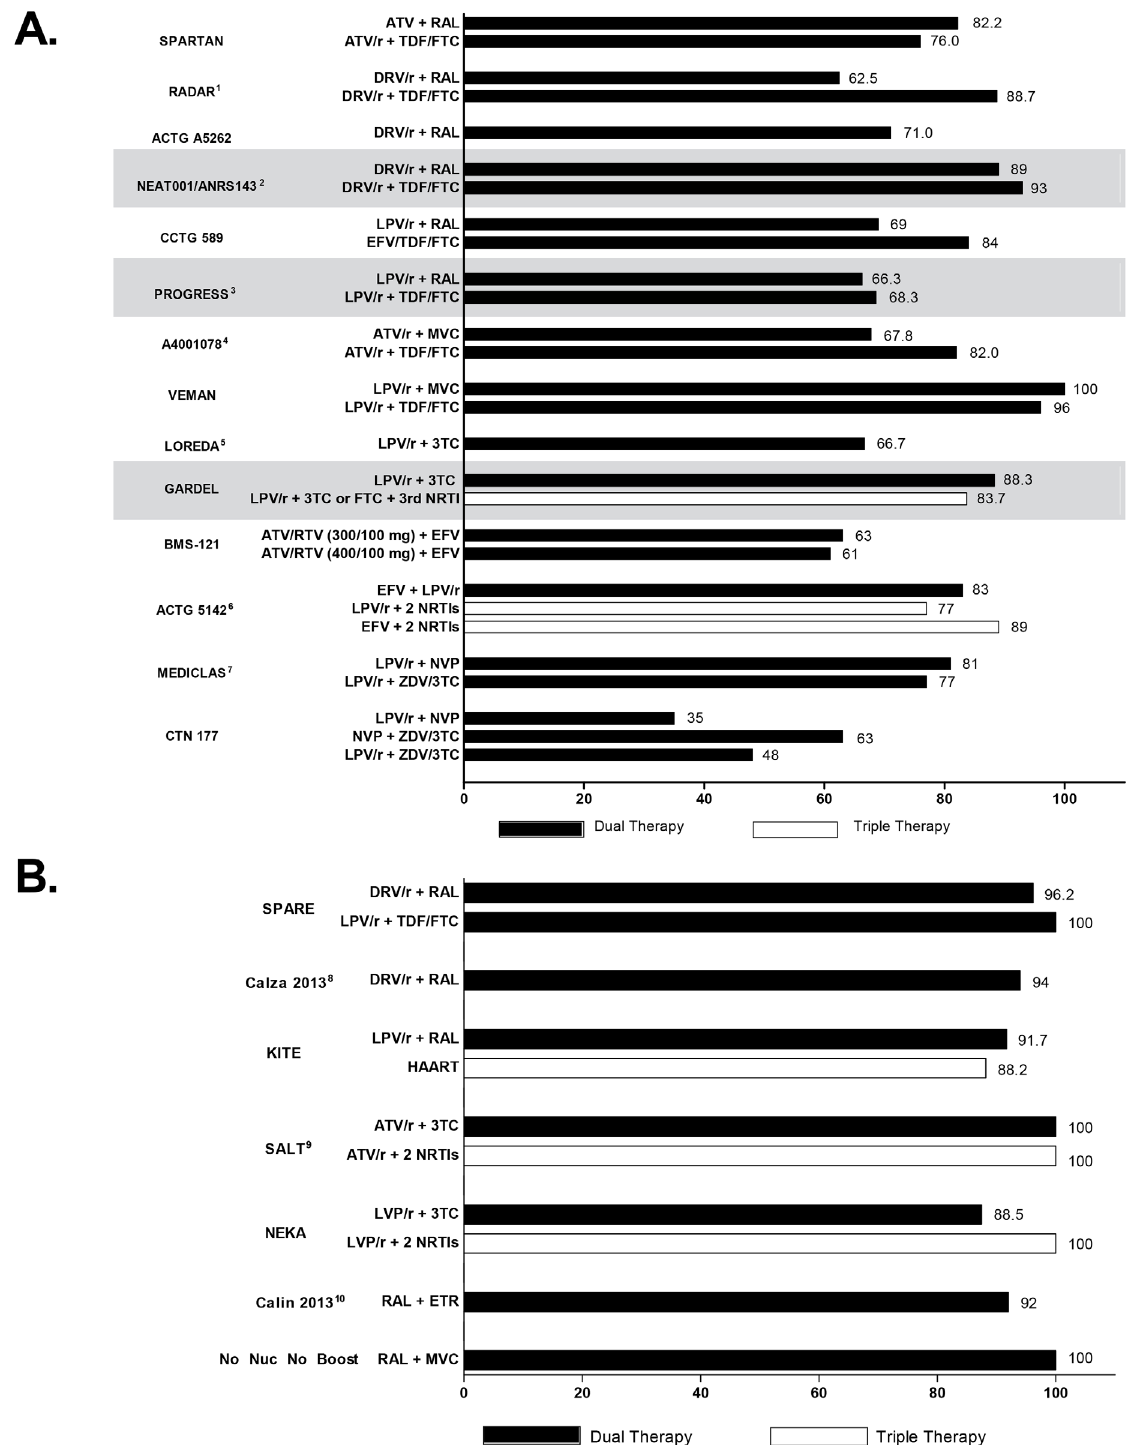
Fig 2. Efficacy of therapy by regimen in A) in ARV-naive, and B) ARV-experienced, virologically suppressed patients. Percentage indicated shows subjects with HIV-1 RNA < 50 copies/mL at week 48. Studies that were randomised and sufficiently powered for direct comparison of standard and dual therapy regimens are shaded. 1 < 48 copies/mL; 2 at 96 weeks; 3 < 40 copies/mL; 4 at 96 weeks; 5 < 48 copies/mL; 6 at 96 weeks; 7 at 24 months; 8 at 12 months; 9 at week 24; 10 < 80 copies/mL. ARV, antiretroviral.